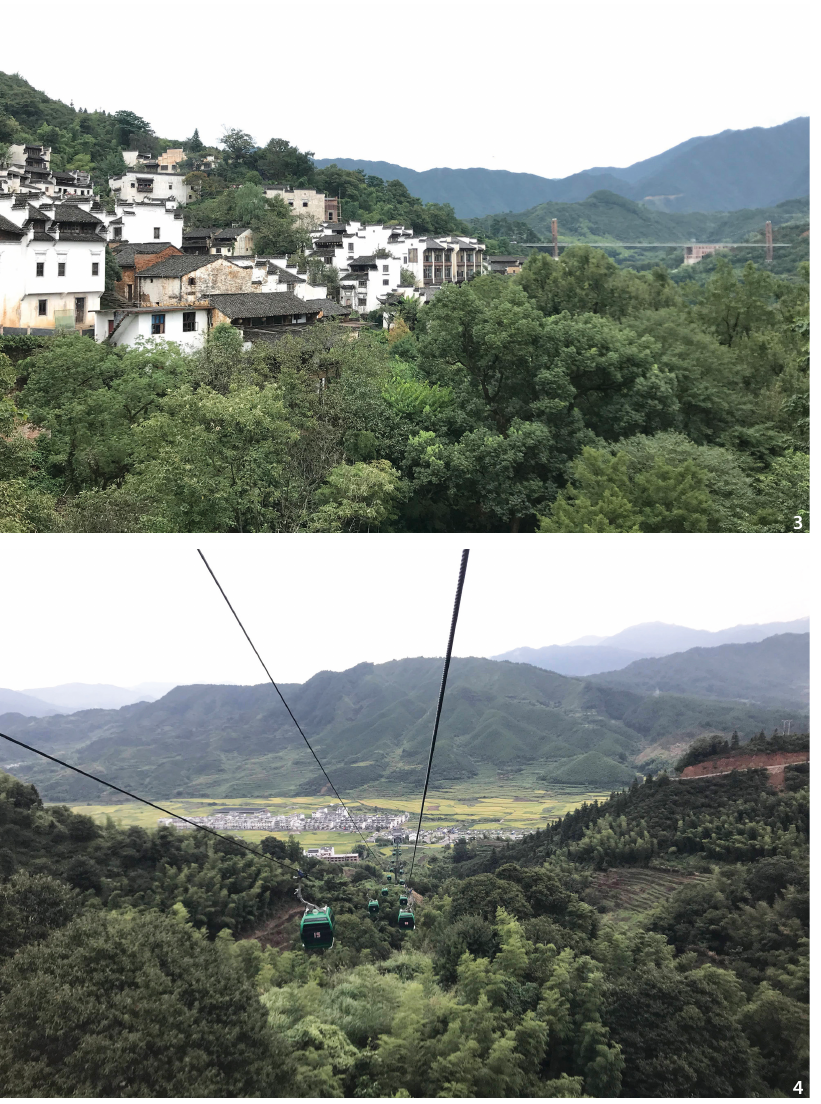
Village, Wuyuan County, Shangrao, Jiangxi Province, September 2018 (Source: